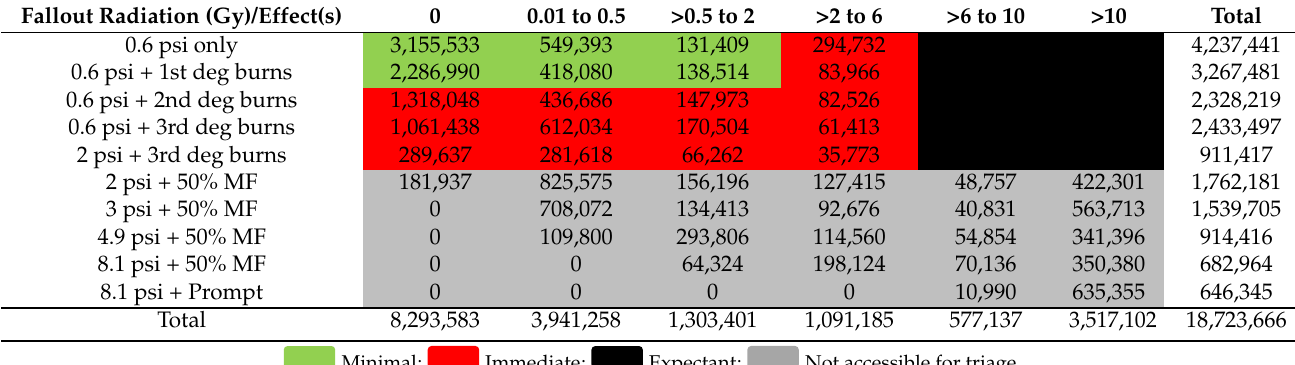
Table 8. Human casualties due to combined injuries (1 mt nuclear weapon).